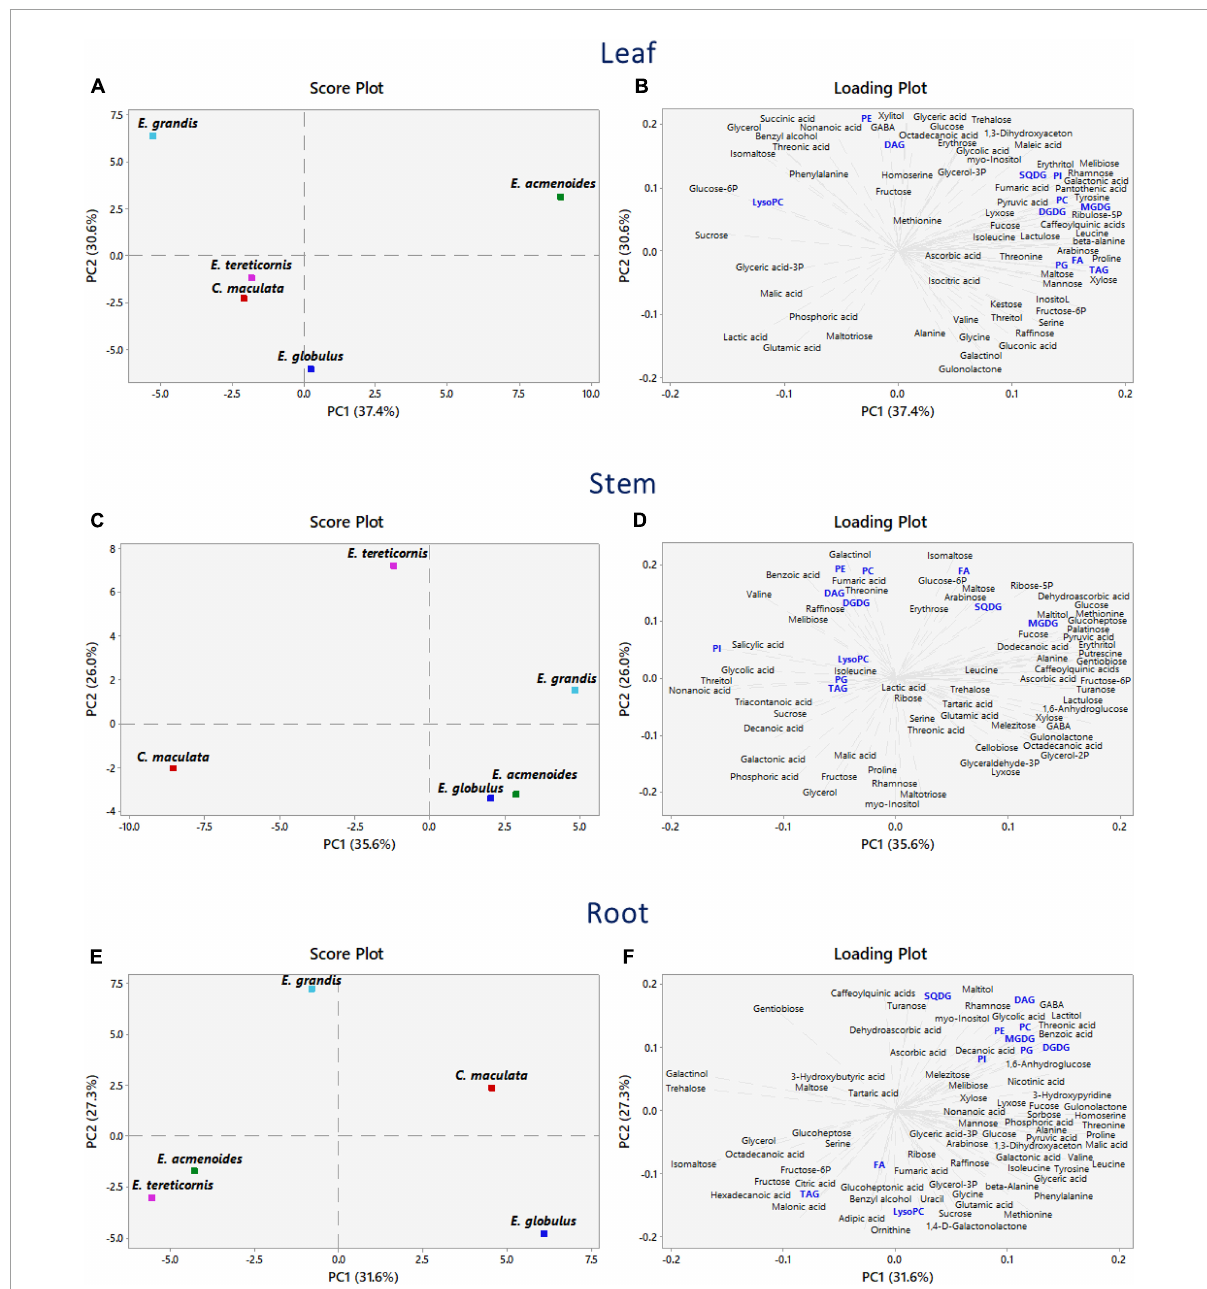
FIGURE3 Principal component analysis combining metabolomic and lipidomic profiles from five eucalypt species cultivated in soil with low (Low P) and sufficient (Suf P) availability of phosphorus. The analysis was performed by the changes of log2 ratios (Low P/Suf P) metabolic contents in leaves, stems and roots, individually. Numbers in parentheses indicate the percentual variation of the first (PC1) and the second (PC2) principal components. (A,C,E) Show the scores and (B,D,F) show the loading plots. Lipids are in blue. Monogalactosyldiacylglycerol (MGDG), digalactosyldiacylglycerol (DGDG), sulfoquinovosyldiacylglycerol (SQDG), fatty acid (FA), phosphatidylinositol (PI), phosphatidylglycerol (PG), phosphatidylcholine (PC), phosphatidylethanolamine (PE), lysophosphatidylcholine (LysoPC), triacylglycerol (TAG), and diacylglycerol